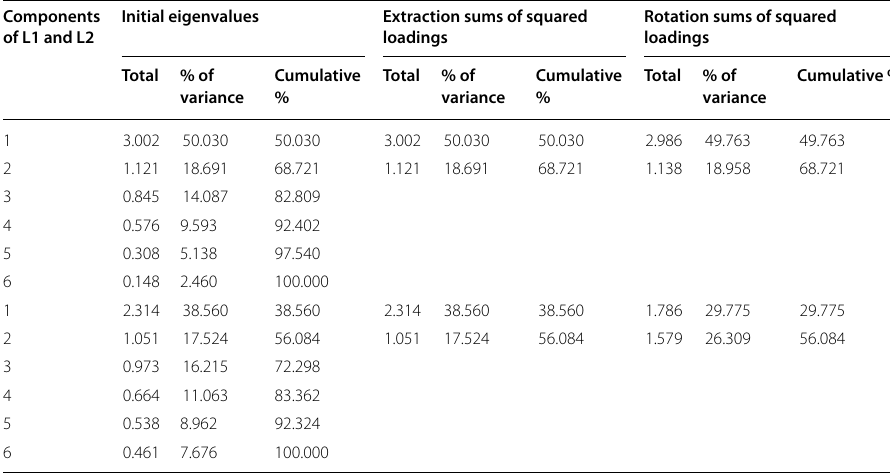
Table 8 Total variance explained for L1 and L2 Use in General Components of L1 and L2